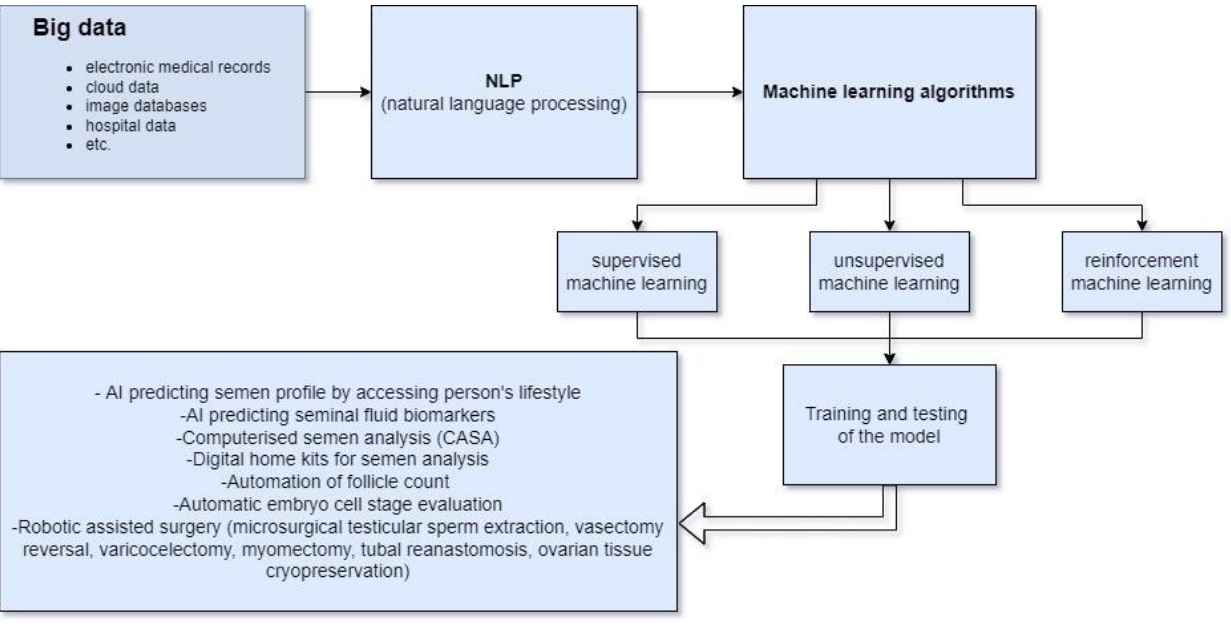
Figure 1. Usage of AI in reproductive medicine.